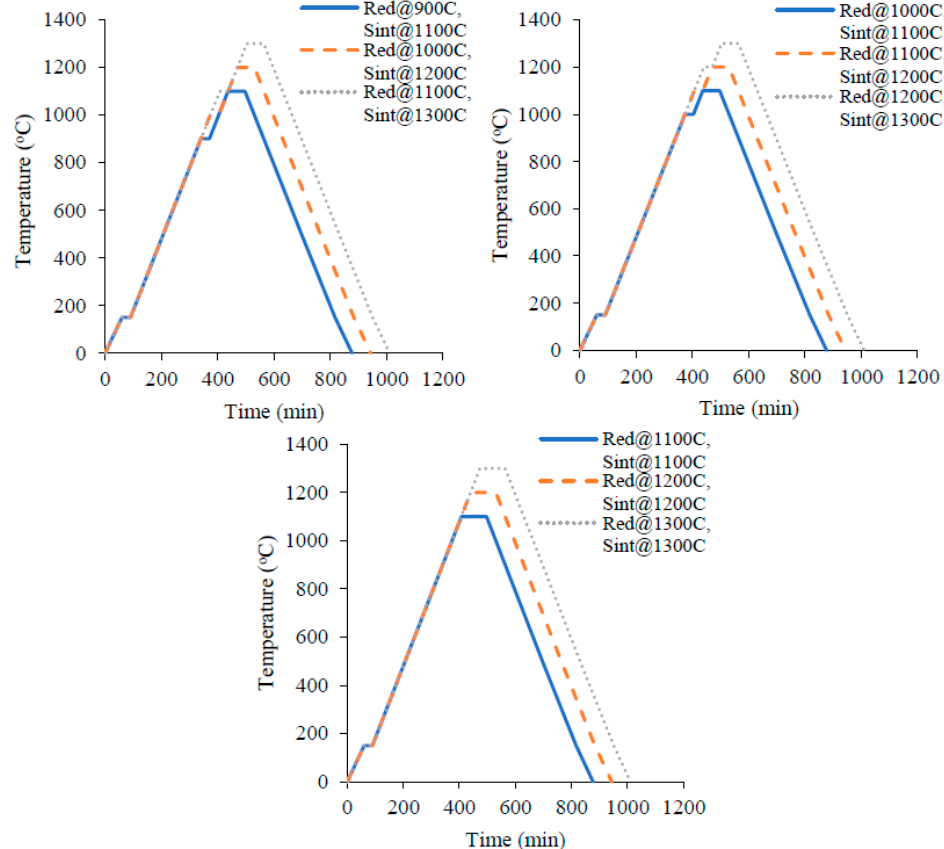
Figure 6. Sintering cycles for different reduction and sintering temperatures.